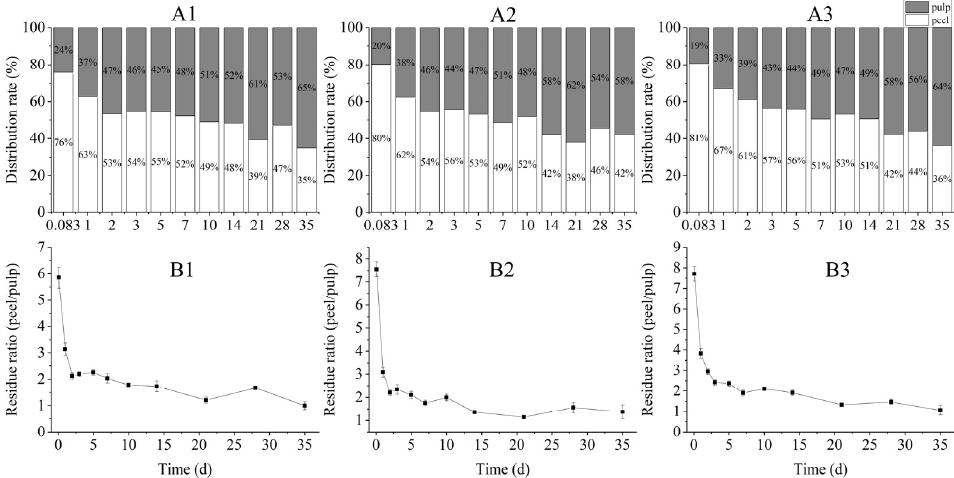
Figure 6. Distribution rate of prochloraz on the banana peel and pulp from the bananas from Guangdong ( A1 ), Hainan ( A2 ), and Yunnan ( A3 ); residual prochloraz ratio of the banana peel to pulp from Guangdong ( B1 ), Hainan ( B2 ), and Yunnan ( B3 ). Data are presented as mean ± SE ( n = 3).